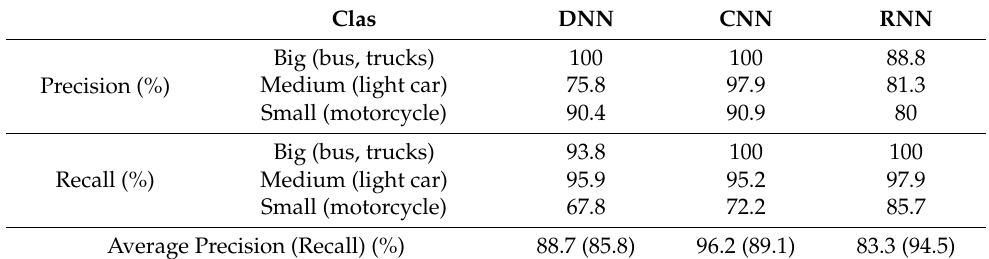
Table 4. Precision and recall of networks on a 15 min data record, including 16 large, 49 medium, and 28 small Vehicles.